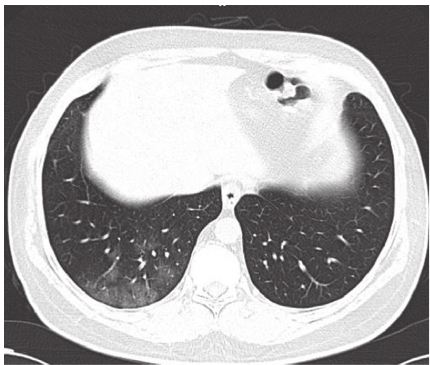
Figure 6: Beginning of GGO at the subclinical phase with non- frequent